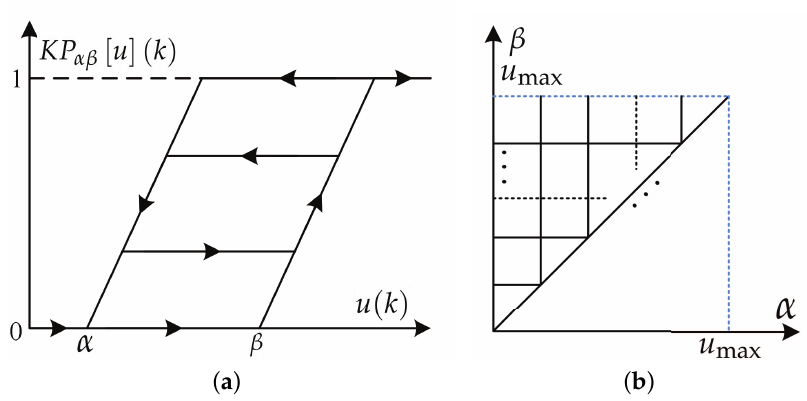
Figure 1. Structure chart of the Krasnosel’skii-Pokrovskii (KP) kernel and Preisach plane. ( a ) KP kernel; ( b ) Preisach